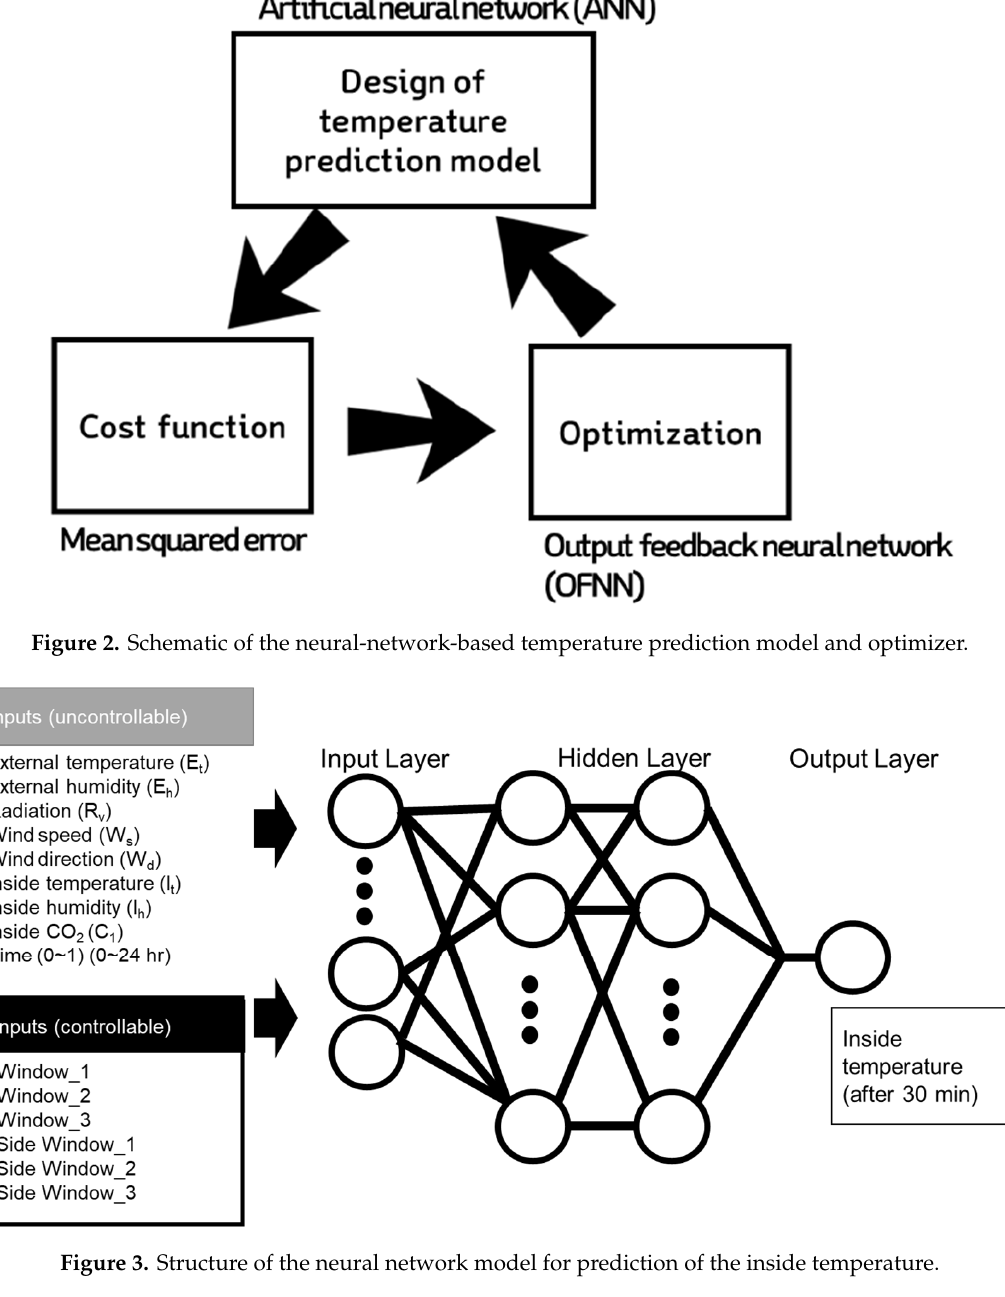
Figure 3. Structure of the neural network model for prediction of the inside temperature.